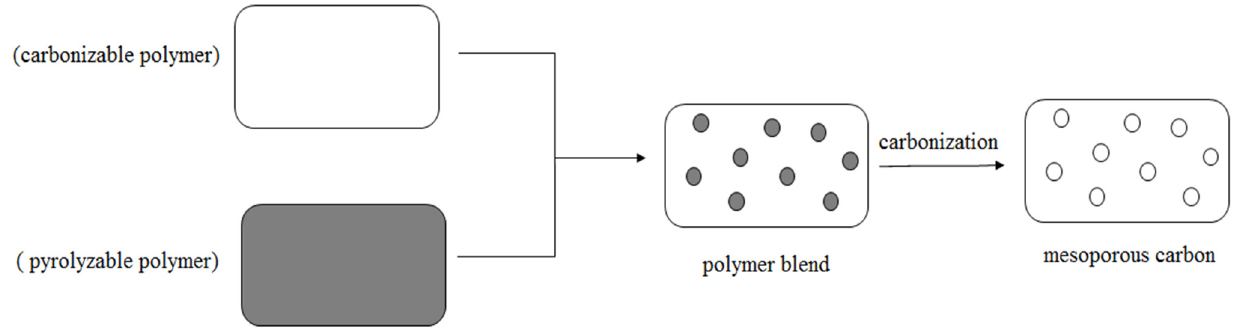
Figure 2. Scheme of the hard-templating method ( a ) and soft-templating method ( b ) in the synthesis of mesoporous carbon materials.